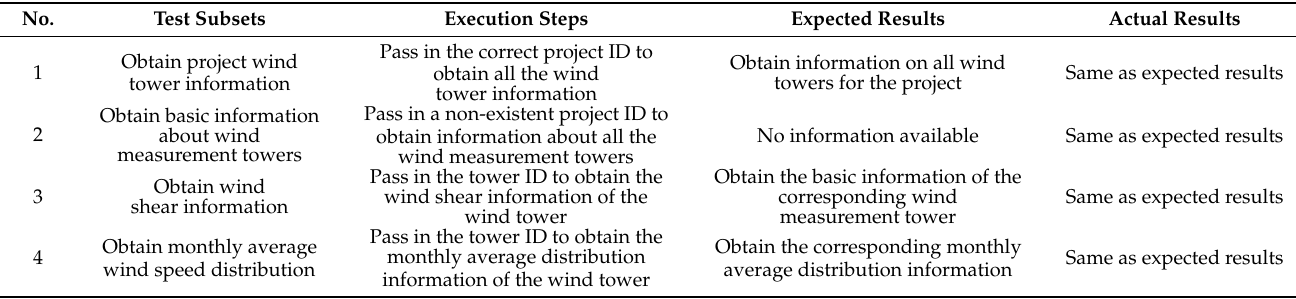
Table 4. Mast API Test